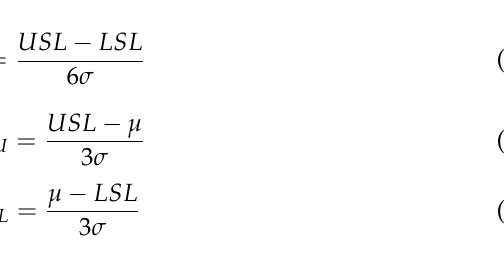
Table 6. Difference between measured and calculated FLD 0 values. FLD 0 ∆ = FLD 0 M − FLD 0 C Material Calculated by Calculated by By By Measured Equation (18) Equation (19) Equation (18) Equation (19) AISI 304 BM